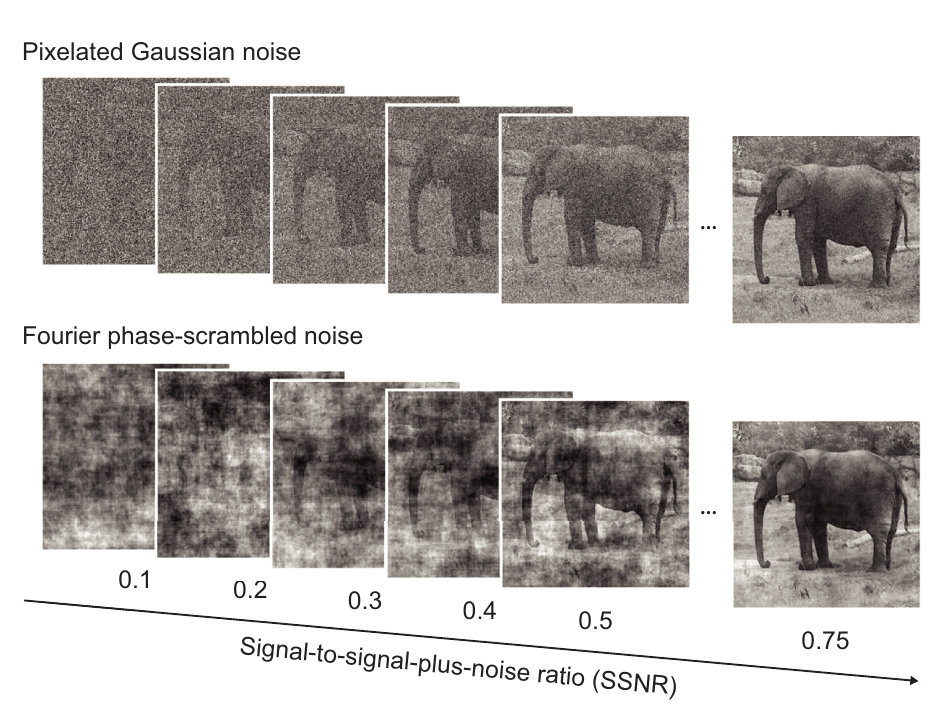
Fig 1. Examples of an object image in pixelated Gaussian noise or Fourier phase-scrambled noise, shown at varying SSNR levels. Elephant image by Frank Tong . SSNR, signal-to-signal-plus-noise ratio.